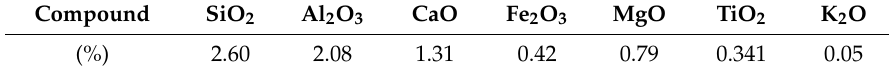
Table 1. Compound contents in the coke powder obtained by X-ray fluorescence (XRF). Compound